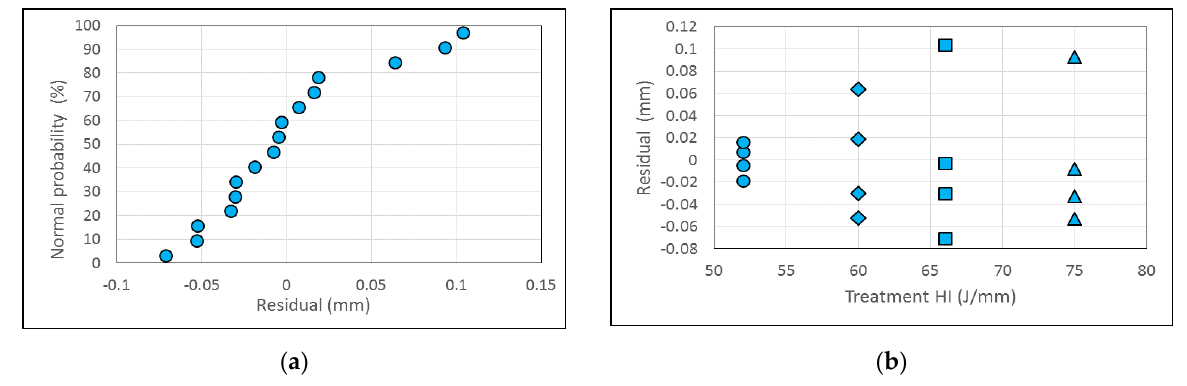
Figure 10. Plots of the residuals for width W: ( a ) normal probability; ( b ) residuals vs HI.